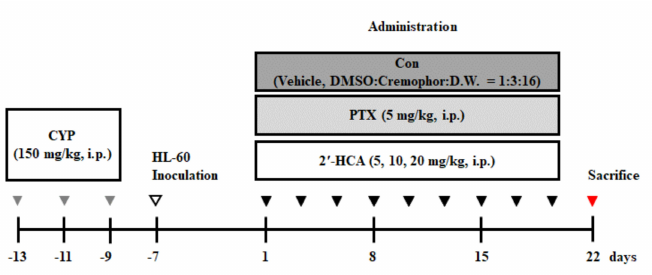
Figure 2. Scheme of the experimental procedure using HL-60 cell-inoculated xenograft animals for assessing the anti-tumor efficacy of 2 (cid:48) -HCA.